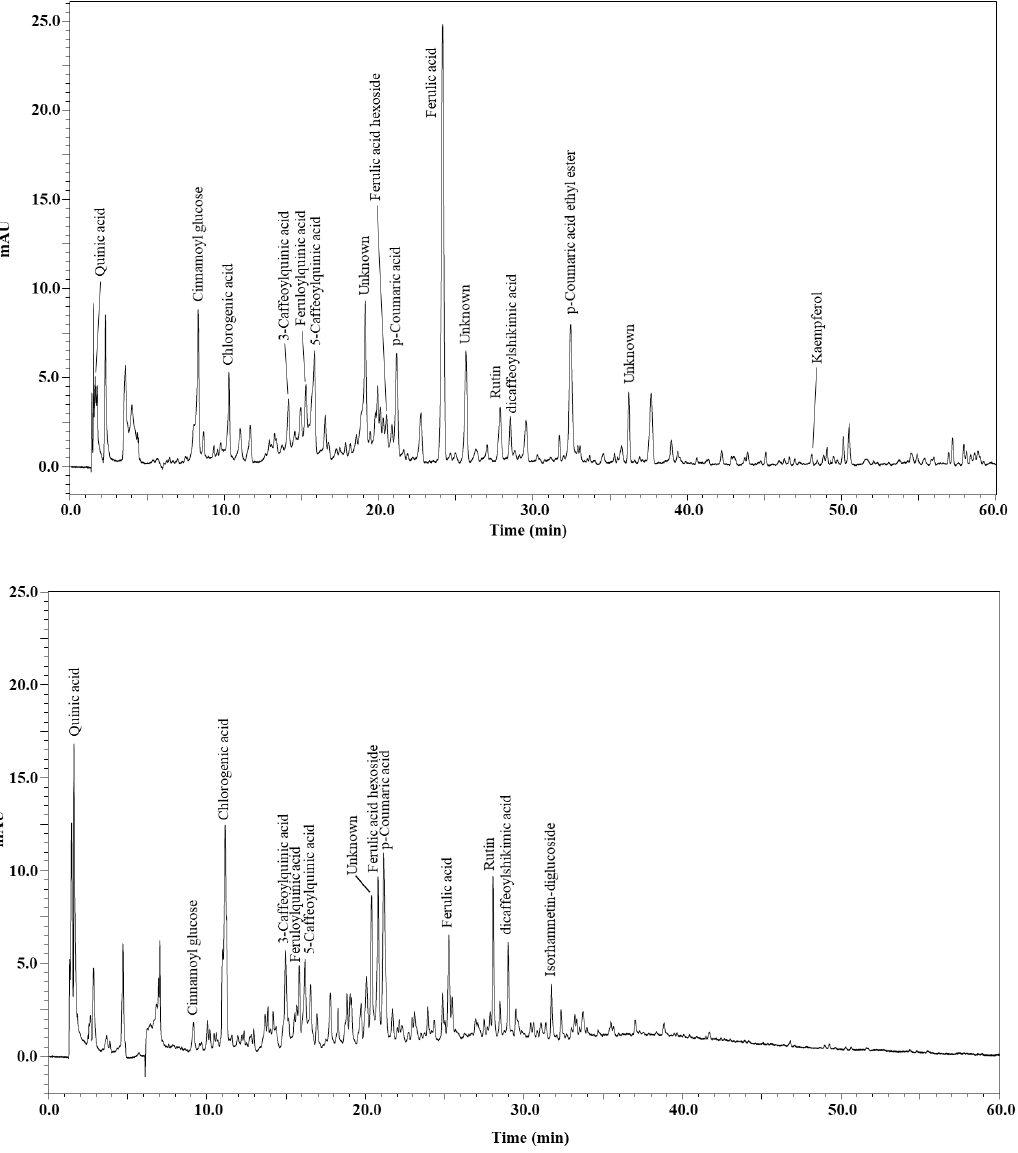
Figure 2. HPLC – PDA polyphenolic profile of the EtOAc (top) and MeOH-H 2 O extracts of C. humilis. Figure 2. HPLC–PDA polyphenolic profile of the EtOAc (top) and MeOH-H 2 O extracts of C. Table 5. Polyphenolic compounds detected in EtOAc extract of C. humilis by HPLC – PDA – ESI/MS. Tentative Identification